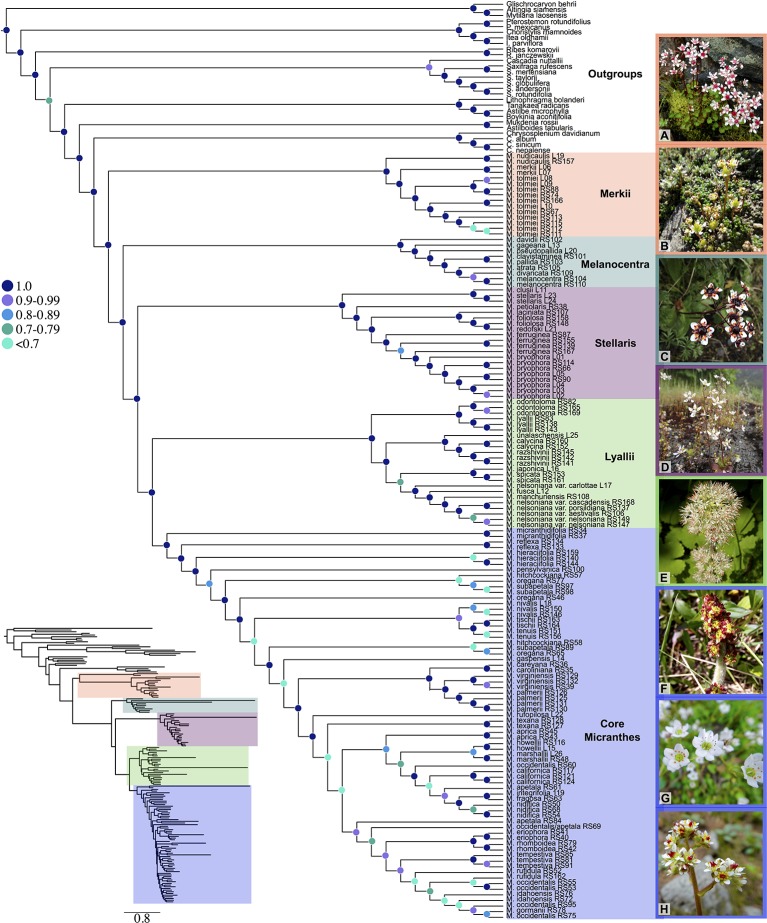
Species tree generated using ASTRAL-II and 481 low-copy nuclear genes. Nodes are colored corresponding to local posterior probability. Additionally, clades are colored to show boundaries of each clade. Inset shows branch lengths generated in RAxML for the ASTRAL-II topology. (A)
Micranthes nudicaulis, (B)
Micranthes tolmiei, (C)
Micranthes melanocentra, (D)
Micranthes ferruginea, (E)
Micranthes manchuriensis, (F)
Micranthes hieraciifolia, (G)
Micranthes californica, (H)
Micranthes tempestiva. All photos by RLS.